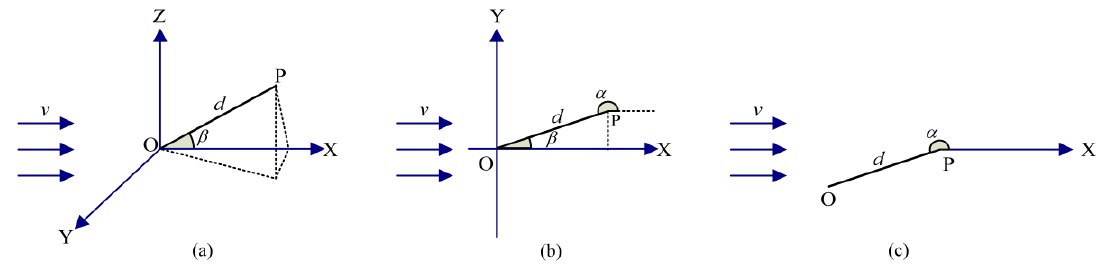
Figure 1. Coordinate systems used in this paper. ( a ) 3-dimensional Cartesian coordinate system; the distance between O and P is d cm, the angle between OP and OX is β